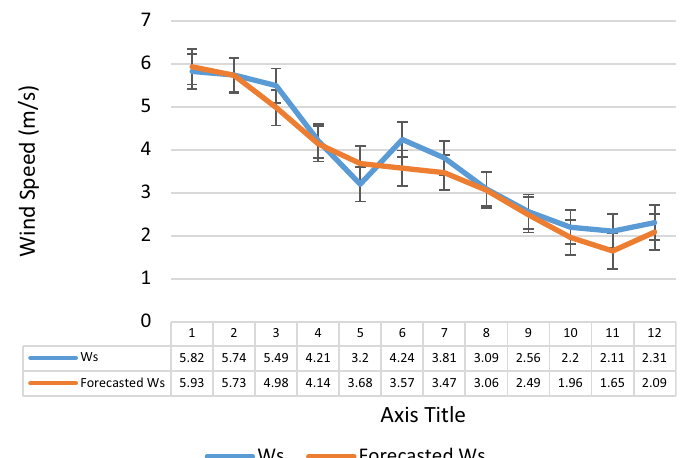
Fig. 29 Validation target and forecasted wind speed